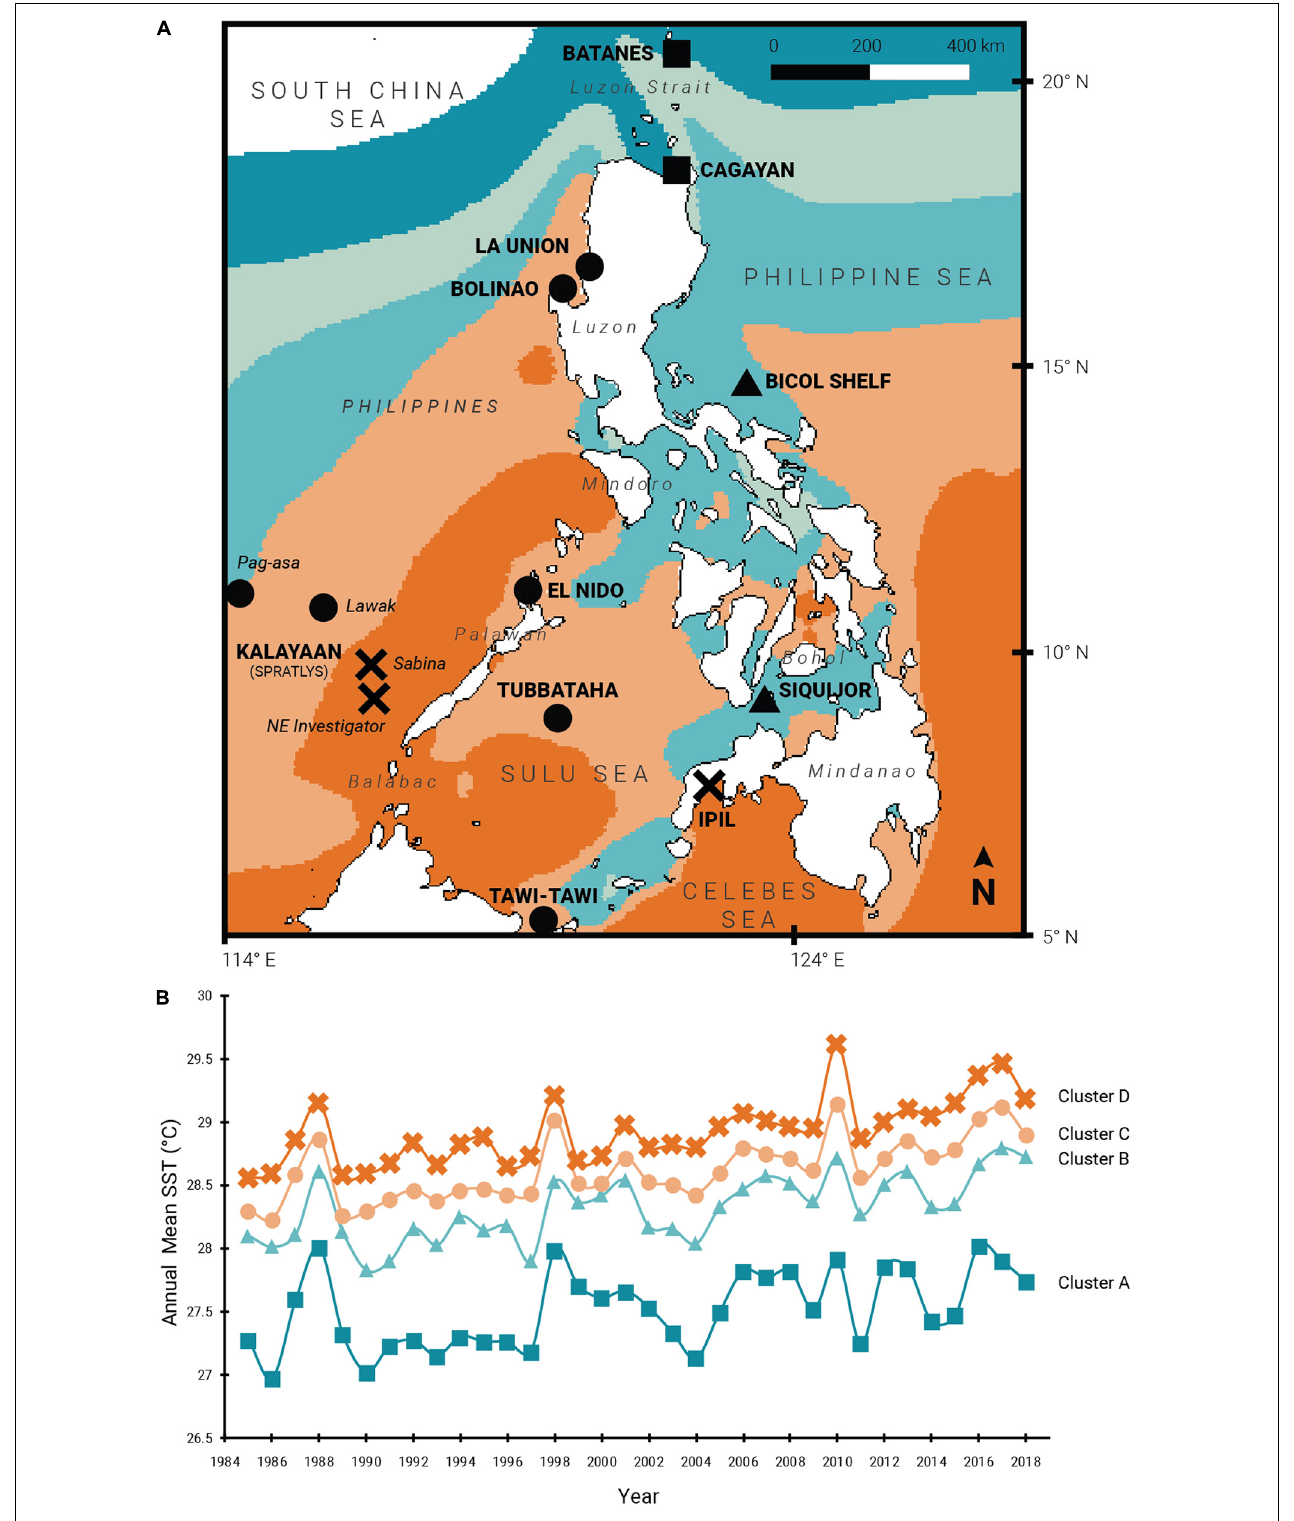
FIGURE 1 | Thermal regimes across the Philippine archipelago. (A) 14 study sites representing four thermal regions clustered using SST data obtained from 1985 to 2018; (B) Annual mean SSTs of clusters A–D from 1985 to 2018. Site symbols correspond to thermal cluster membership: square (cluster A), triangle (B), circle (C), and cross